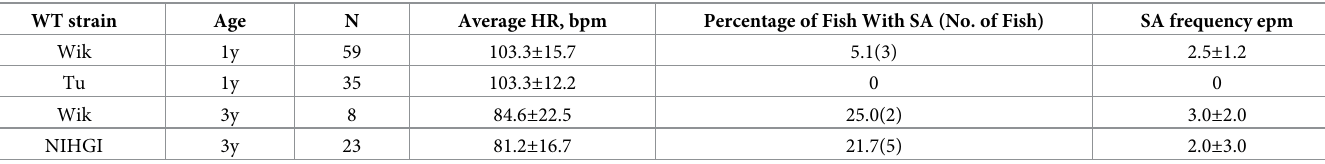
Table 2. SA incidence in different WT